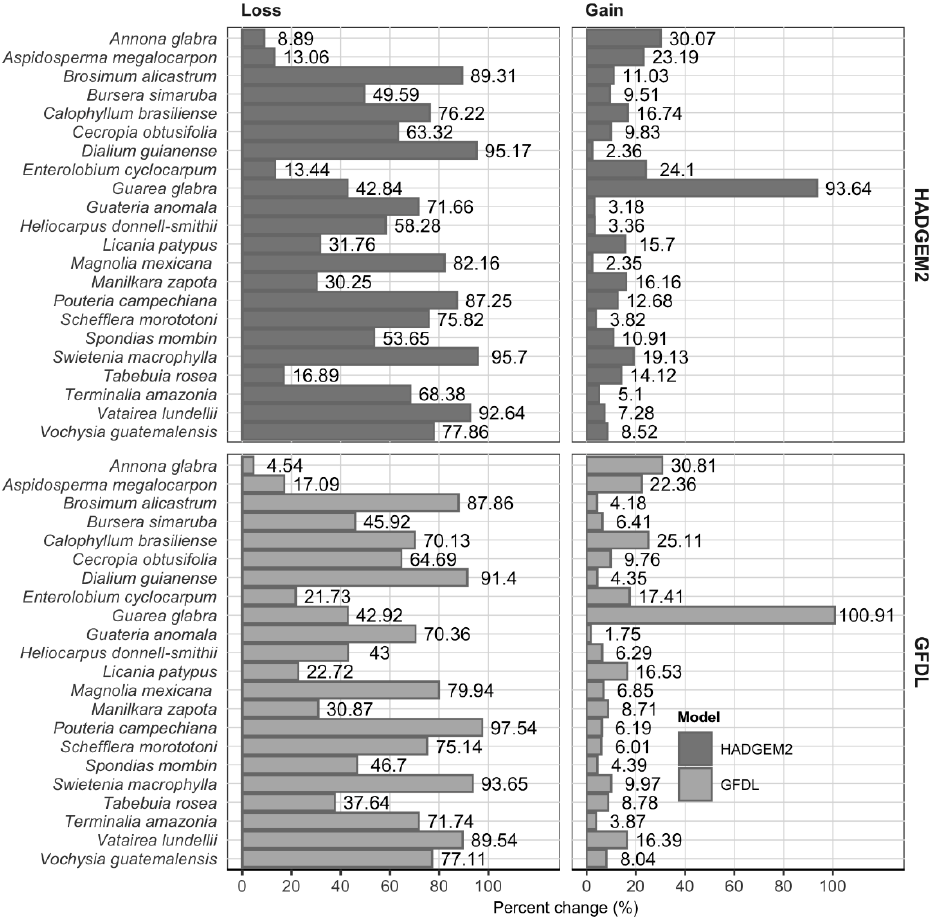
Figure 6. Changes (percentage) in the potential distribution area of all species considered in the climate change scenarios. (loss refers to the area currently occupied by a given species that will no longer be suitable in the future; gain is for new areas outside the current distribution that will be suitable in the future).